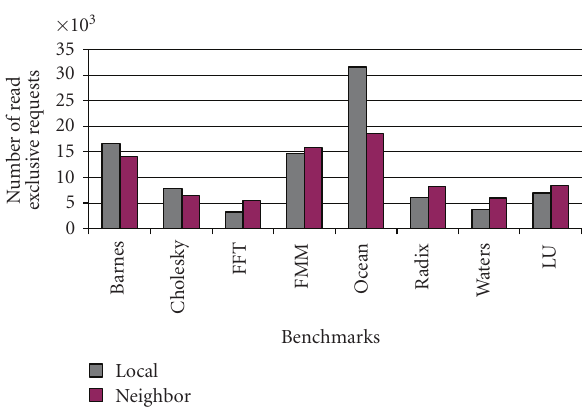
Figure 18: Profiling results for read exclusive